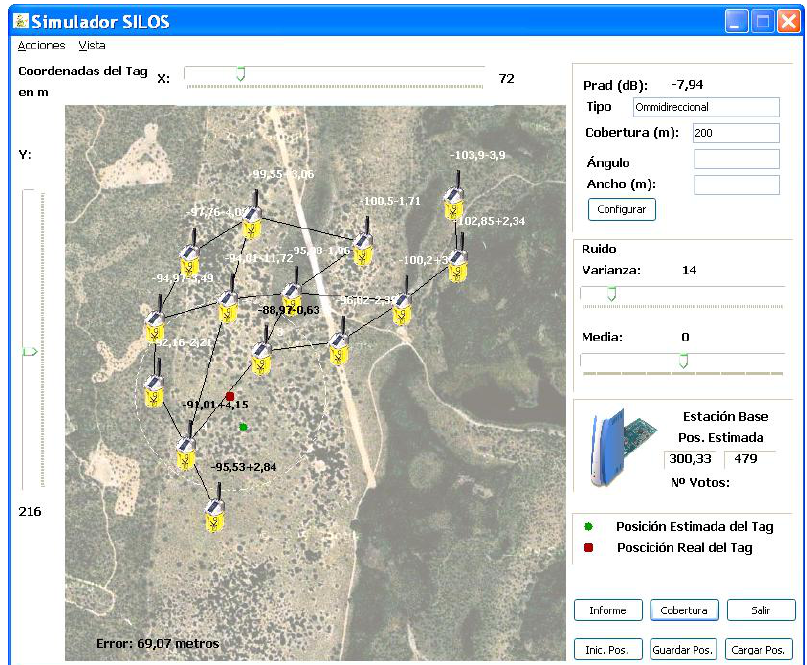
Figure 9. LIS Graphics Environment.